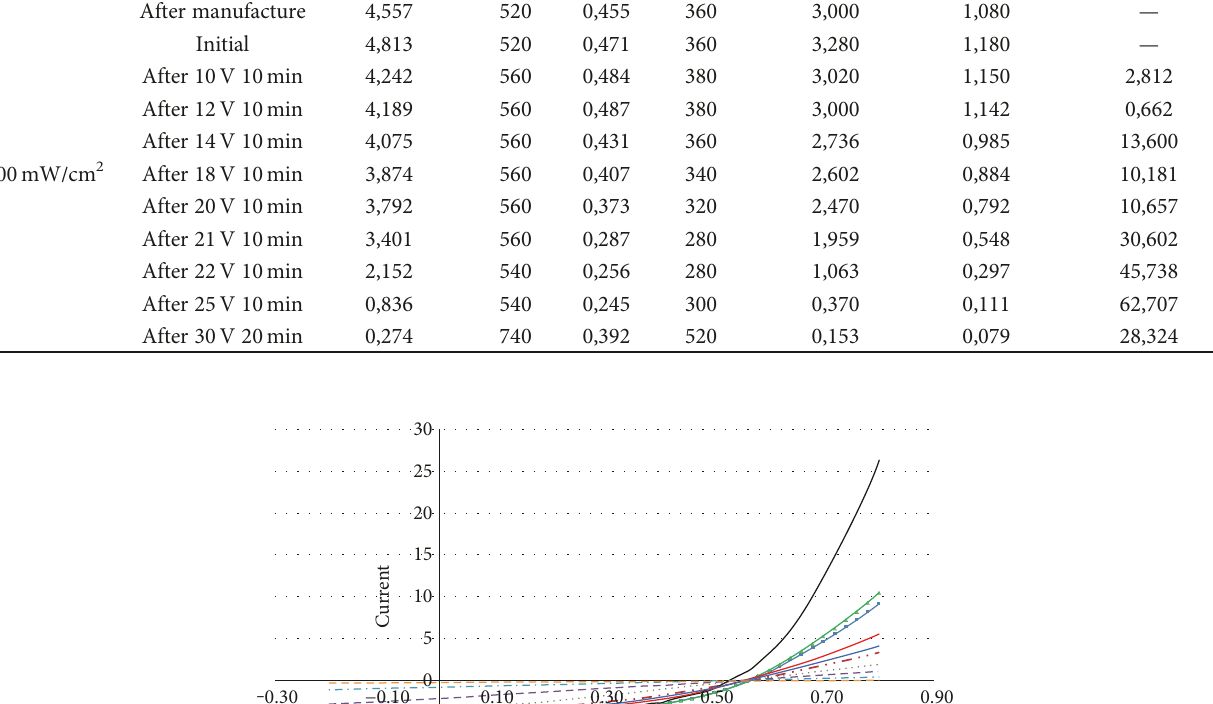
Table 3: Device 4 fi nger 2 voltage-dependent degradation with a 10-minute time interval. Light